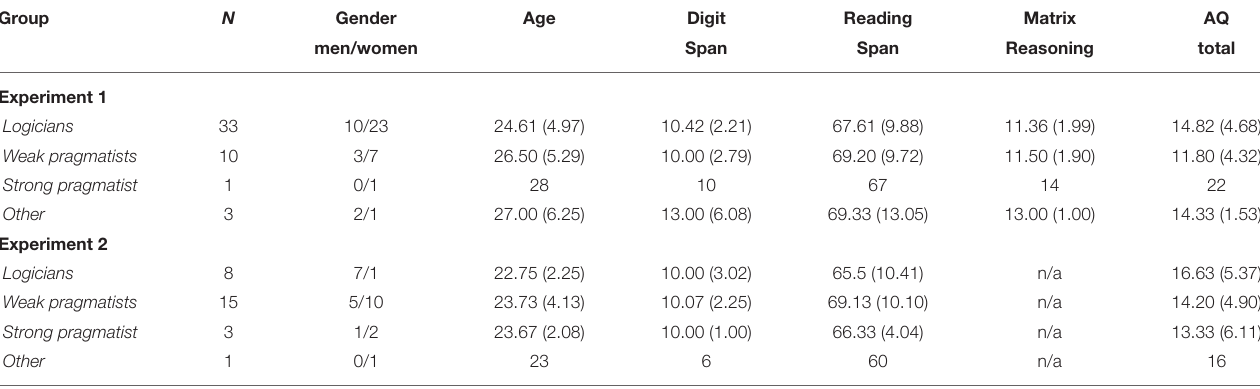
TABLE 3 | Age and gender distribution, as well as the mean values with standard deviations [ M ( SD )] for all cognitive tests, in percentages, per group and per experiment. Group N Gender Age Digit Reading